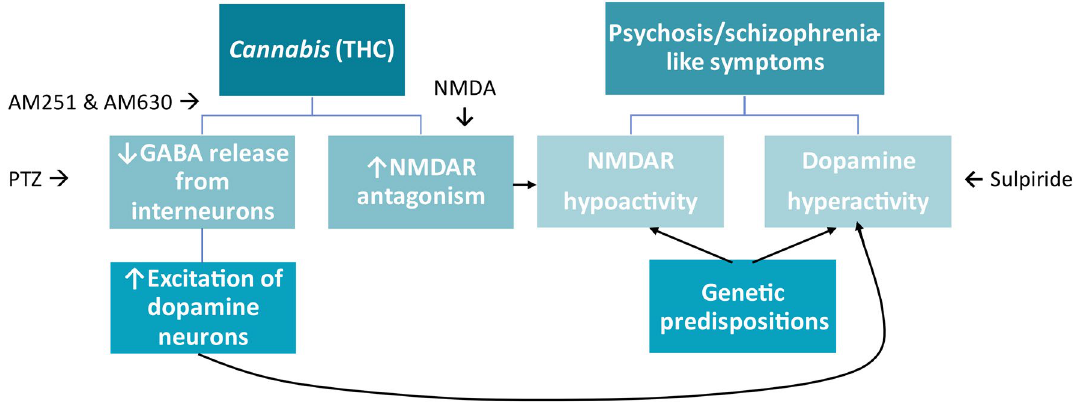
Figure 7. Potential mechanisms underlying the associations between Cannabis consumption and risks of psychosis/schizophrenia-like symptoms, with the current study’s pharmacological approaches. Δ9-tetrahydrocannabinol (THC) reduces N-methyl-D-aspartate (NMDA) release via NMDA receptor antagonism. THC also inhibits γ ‐ aminobutyric acid (GABA) release from interneurons in the prefrontal cortex, potentiating dopamine release. Both NMDA receptor hypoactivity and heightened dopaminergic signaling are hallmarks of schizophrenia. Pentylenetetrazol